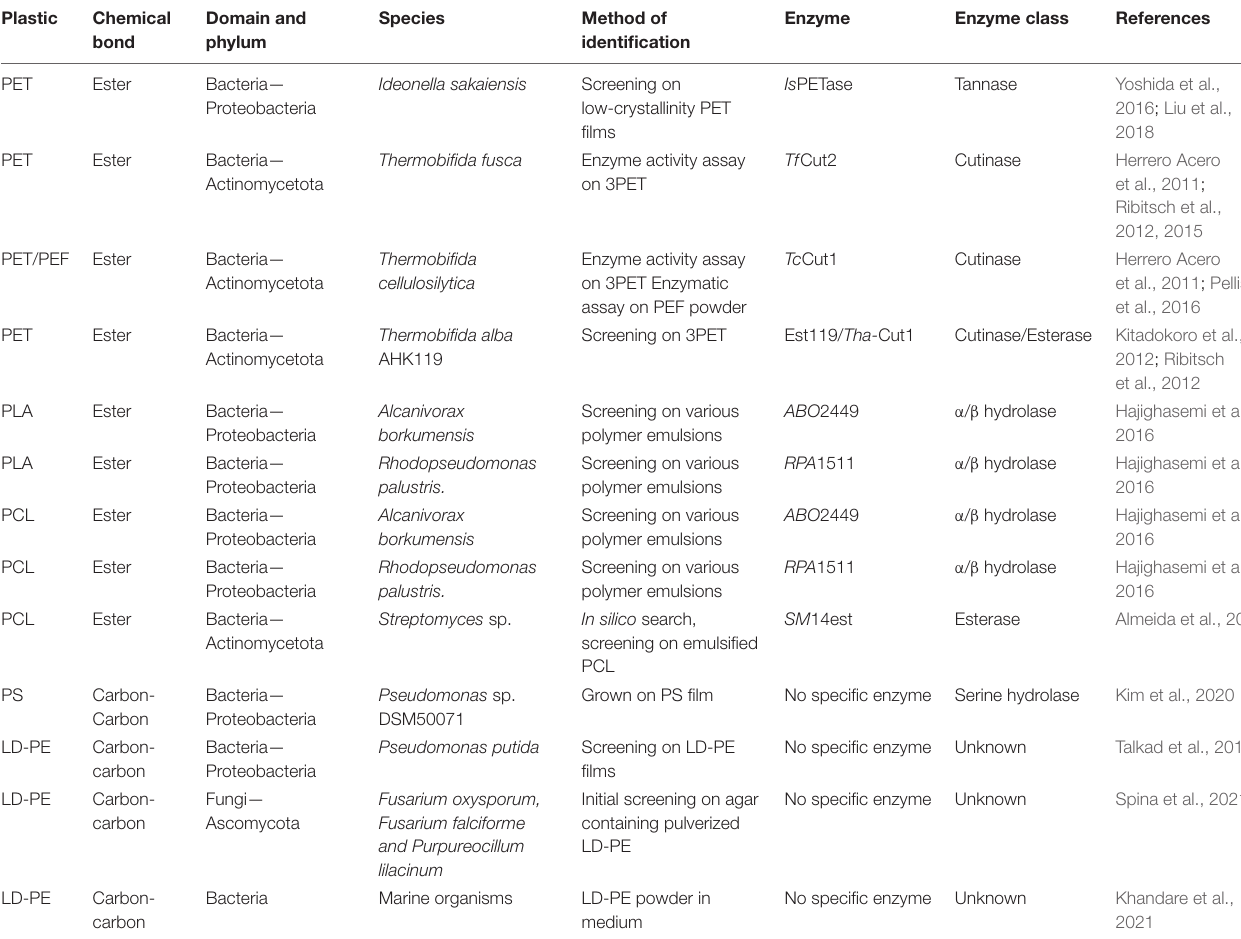
TABLE 1 | Comprehensive overview of enzymes discussed in this